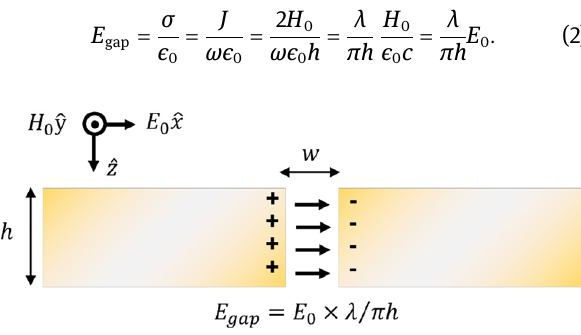
Figure 2: Cross-sectional schematic sketch of an infinite slit with width w and thickness h